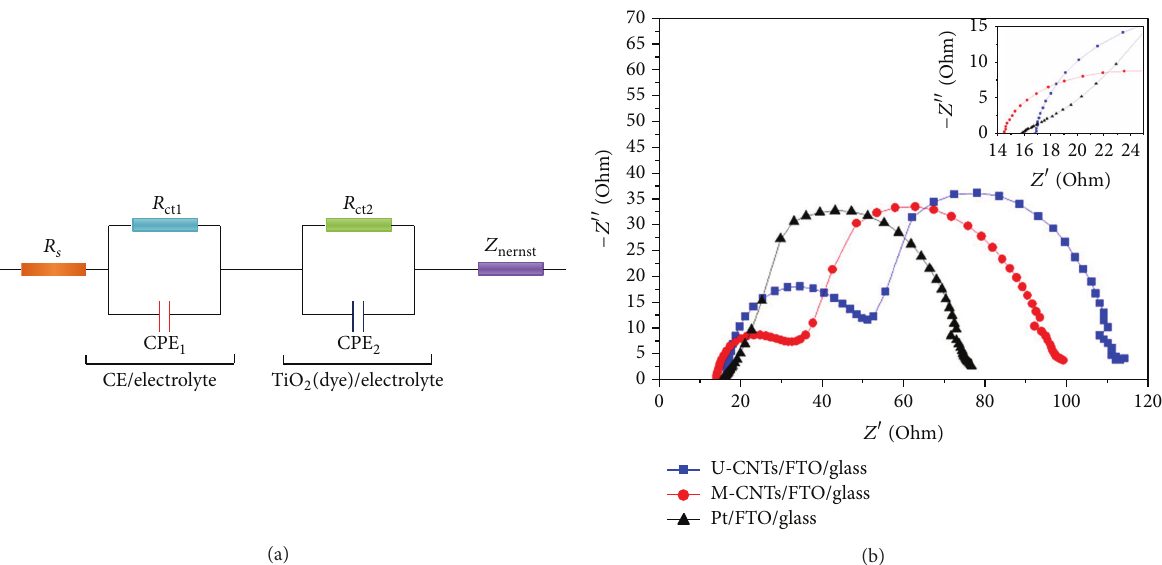
Figure 6: (a) The equivalent circuit of glass DSSCs and (b) Nyquist plots of the Pt/FTO, U-CNTs/FTO, and M-CNTs/FTO DSSCs.